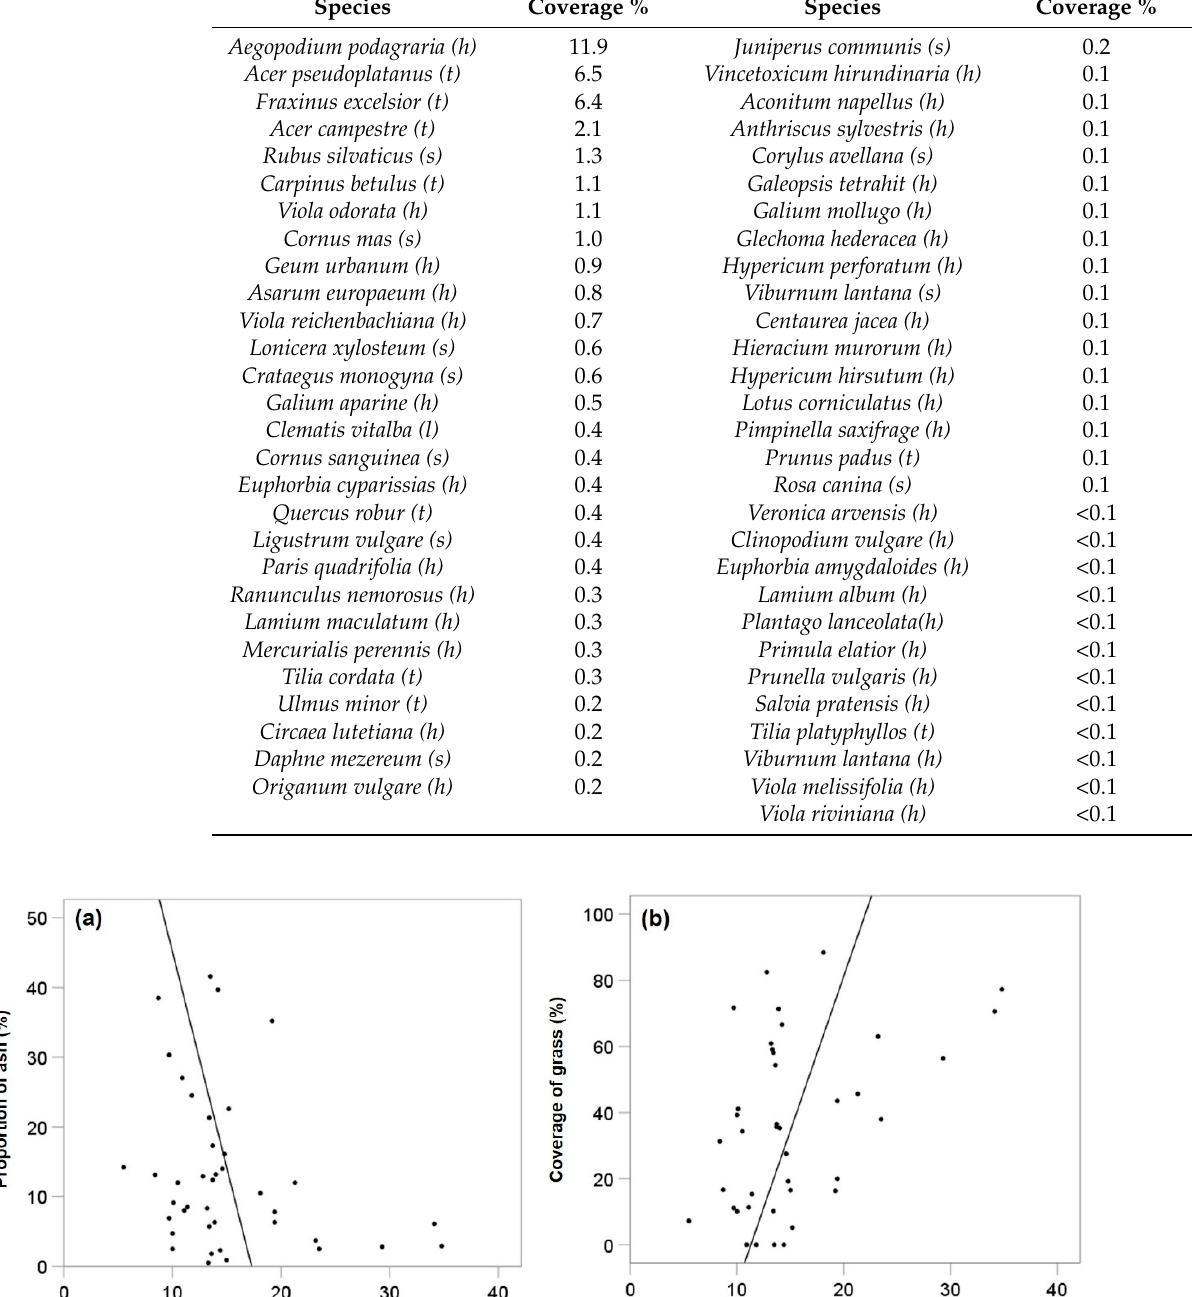
Table 2. Observed species and their coverage in the understorey at the 40 studied plots, t = tree, s = shrub, h = herb, l = liana.